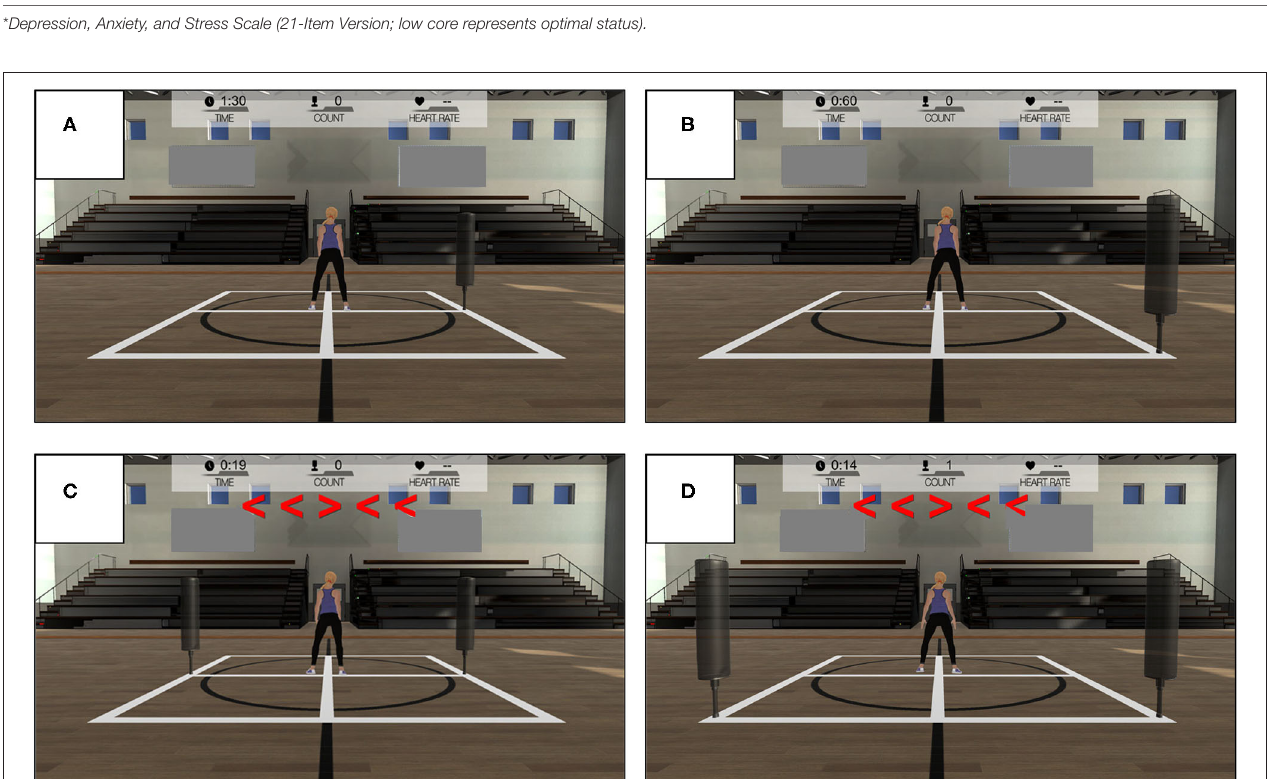
The system used to administer the task (TRAZER R (cid:13) Sports Stimulator, Traq Global Ltd; Westlake, OH) has been shown to provide good test-retest measurement reliability and a valid representation of movement precision in deactivation of virtual targets (Hogg et al., 2021). From a central starting position, each reactive movement in a left or right direction was performed